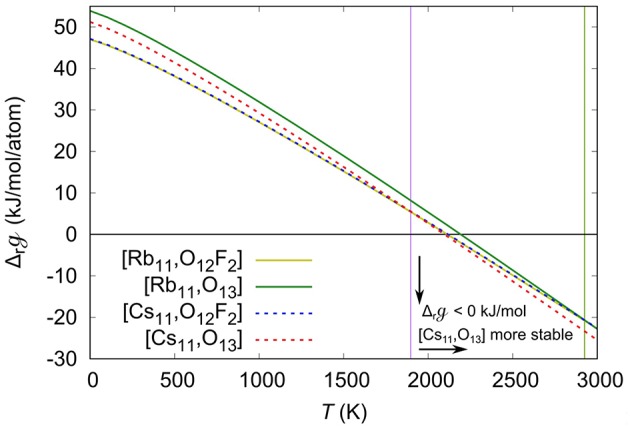
Quasi-Gibbs reaction energies (Δrg), in kJ/mol/atom, as a function of the temperature (T), in K. The ΔrG of the Rb11(UO2)12(PO4)3O12F2 ([Rb,O12F2]), Rb11(UO2)12(PO4)3O13 ([Rb,O13]) Cs11(UO2)12(PO4)3O12F2 ([Cs,O12F2]), and Cs11(UO2)12(PO4)3O13 ([Cs,O13]) are shown in yellow, green, blue and red lines, respectively. The purple and green vertical lines respectively show the temperature at which the CsO13 and RbO13 become more stable than the CsO12F2 and RbO12F2.